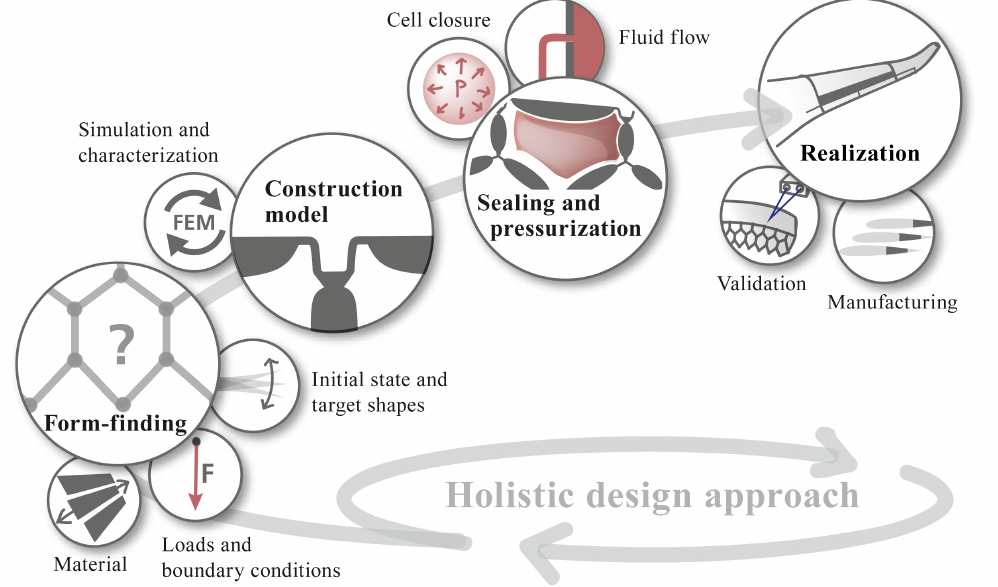
Figure 7. Process chain for a holistic PACS design. Reprinted/adapted by permission from Springer Nature